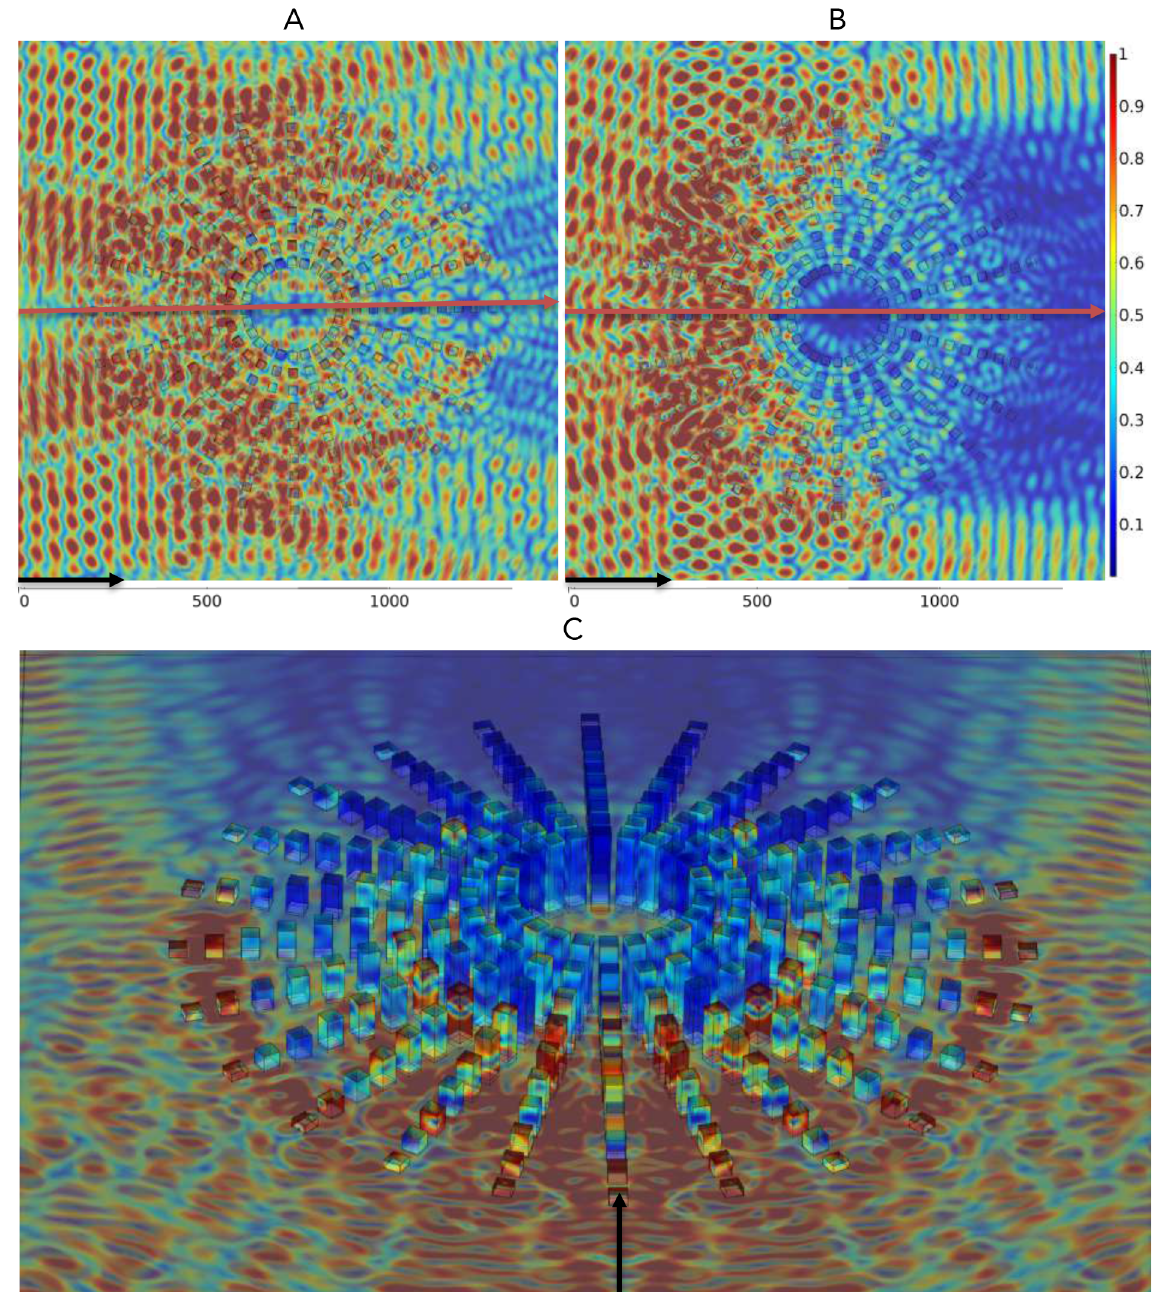
Fig. 7. Scattering of the metacity cloak by a plane wave source at 40Hz with different materials in (A) and (B): (A) concrete buildings on a concrete plate ( E =25e9 [Pa], r = 2300 [kg/m 3 ], n =0.2); (B) consists of steel ( E = 200e9 [Pa], r =7870 [kg/m 3 ], n =0.29) buildings on a concrete plate (right panel). Lower panel (C) is a 3D view of (B) Pro fi le of magnitude of total displacement fi eld integrated along the red segment in (A) and (B) suggests reduction of total displacement by up to 10% in the core of seismic cloak in (A) and reduction of total displacement by up to 80% in the core of seismic cloak as well as behind it in